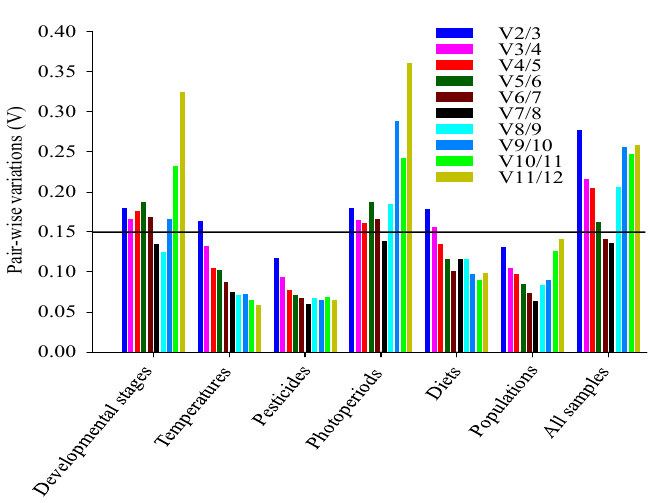
Figure 4. Pair-wise variation (V n /V n + 1 ) analysis of the number of candidate reference genes in B. odoriphaga . Pair-wise variation was analyzed by GeNorm software. A value <0.15 indicates that the normalization could not be dramatically changed by additional reference genes. Table 3. Recommended reference genes in B. odoriphaga under various experimental